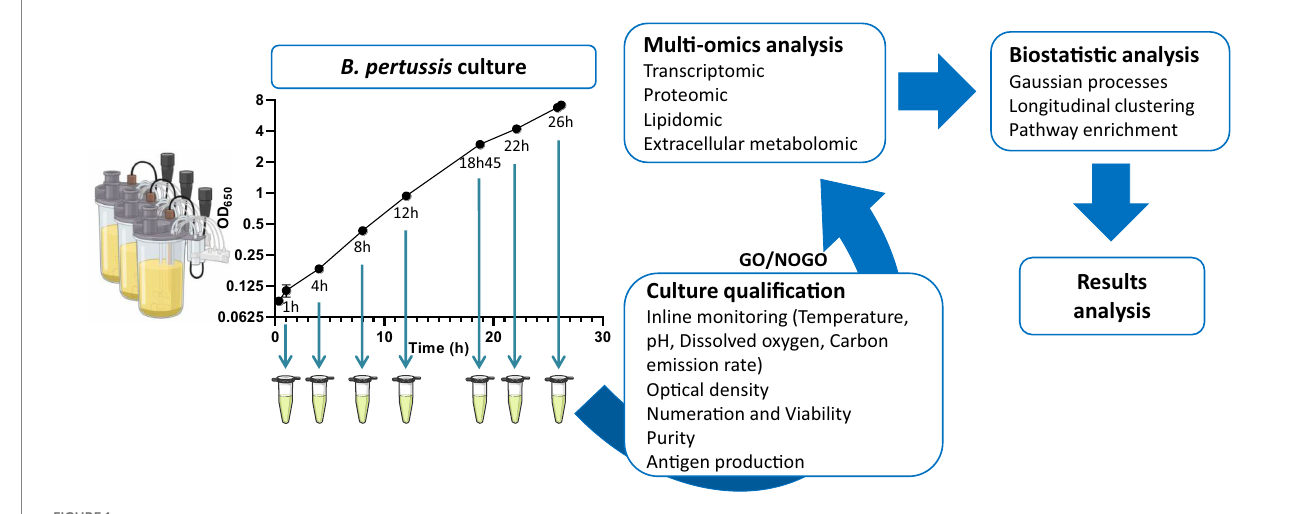
FIGURE 1 Experimental plan of the longitudinal multi-omics study of Bordetella pertussis